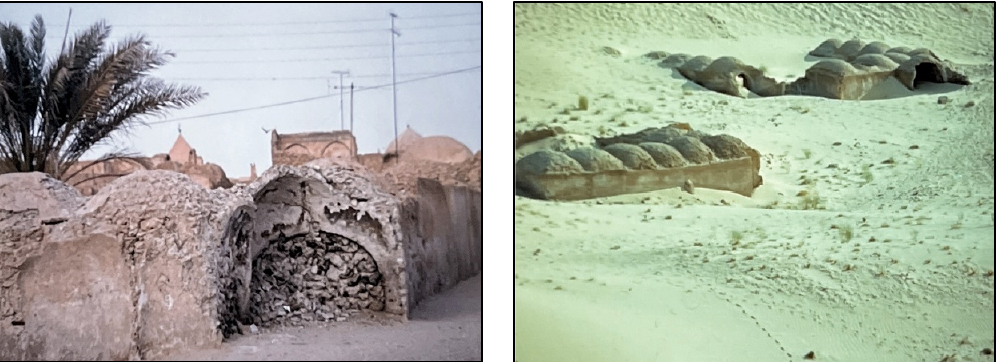
Figure 8. Deterioration ( left ) and burial ( right ) of traditional housing in the town of Gumar, Algeria (photos: M. Sherzad).